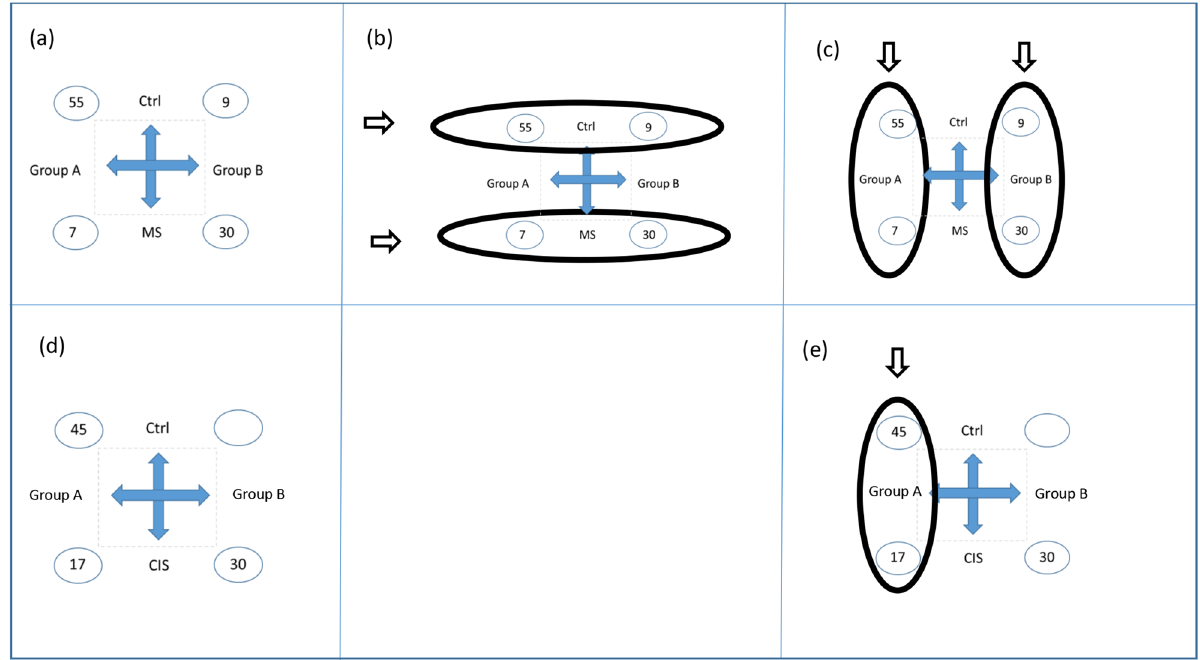
Figure 1. Cohorts 1 and 2. Design of the study. (a–c) Cohort 1: In our previous study of this material 16 the 101 individuals in this cohort were separated based on proteome patterns into two groups here called groups A and B. ( a ) The data of this cohort is considered as influenced by two “pseudofactors”: Group A versus group B and MS versus control, resulting in four combinations of group affiliation and MS status. The four categories of individuals led to a two-factorial design for analyses. The numbers of individuals in each category are indicated in circles. ( b ) Confidence intervals of differences between the groups were analysed within MS patients and within controls. ( c ) Confidence intervals of the differences between MS patients and controls were performed within both groups. ( d and e ) Cohort 2: In analogy to cohort 1, two groups were established. Group A are the IgG-negative individuals. ( d ) For this cohort three combinations of group affiliation and CIS status were present. ( e ) Confidence intervals of the differences in the proteome patterns between CIS and controls were performed within group